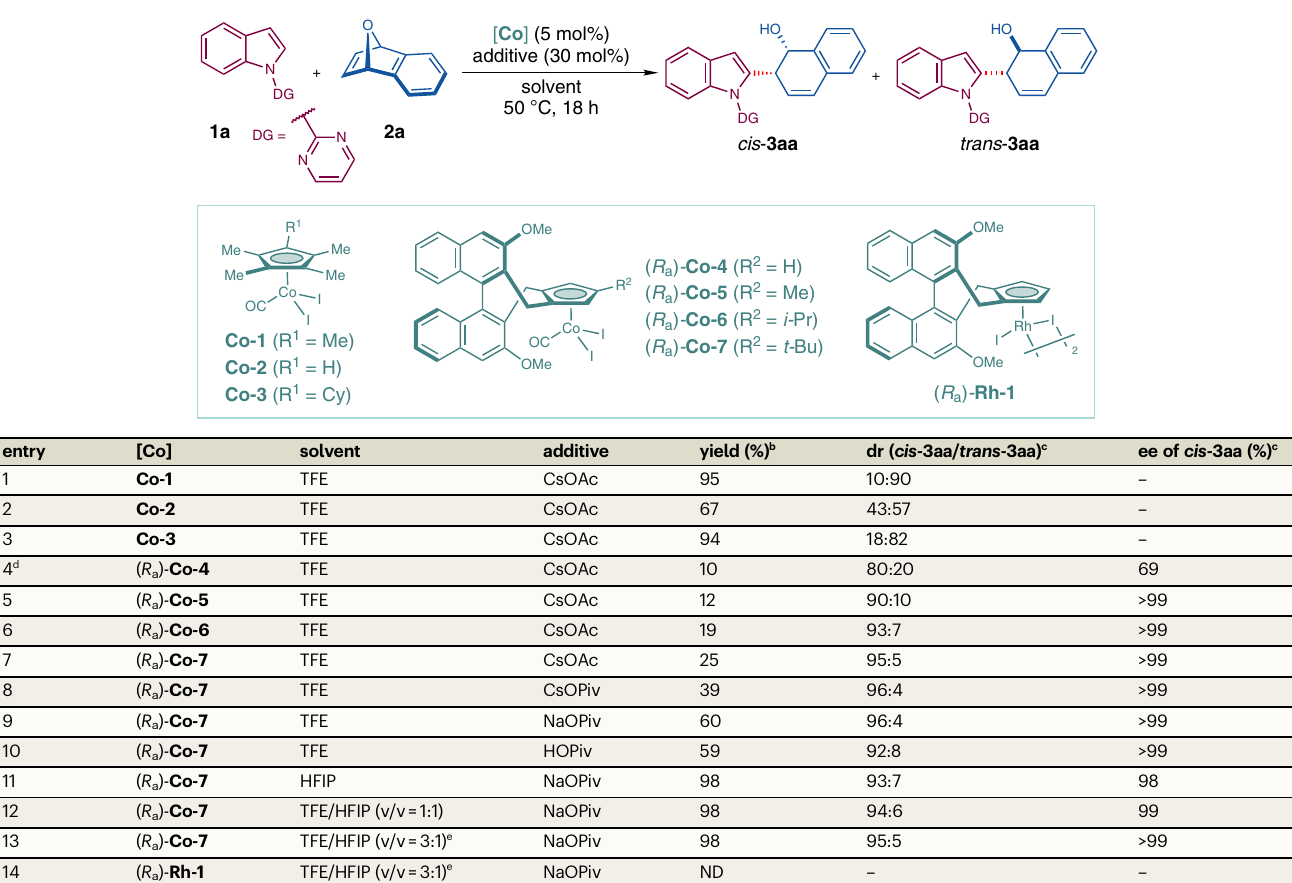
Table 1 | Optimization of reaction conditions